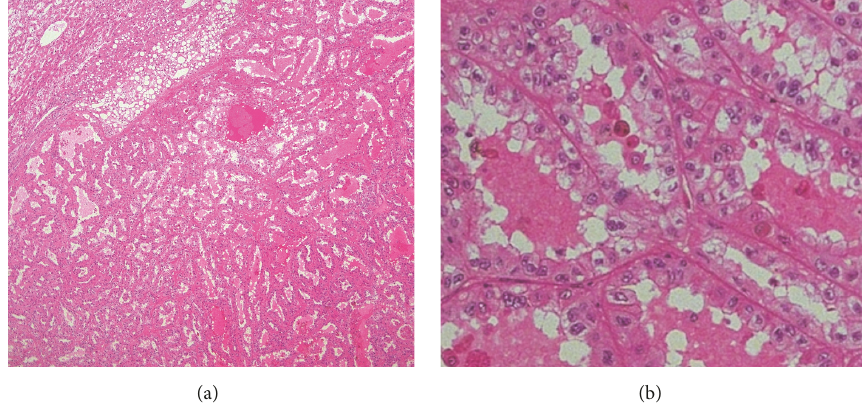
Figure 5: (a) The tumor comprised tubulocystic structured lesions (H&E). (b) Tumor cells have cell mutation with large nucleoli and eosinophilic cytoplasm, cubic and flat, forming small glands.